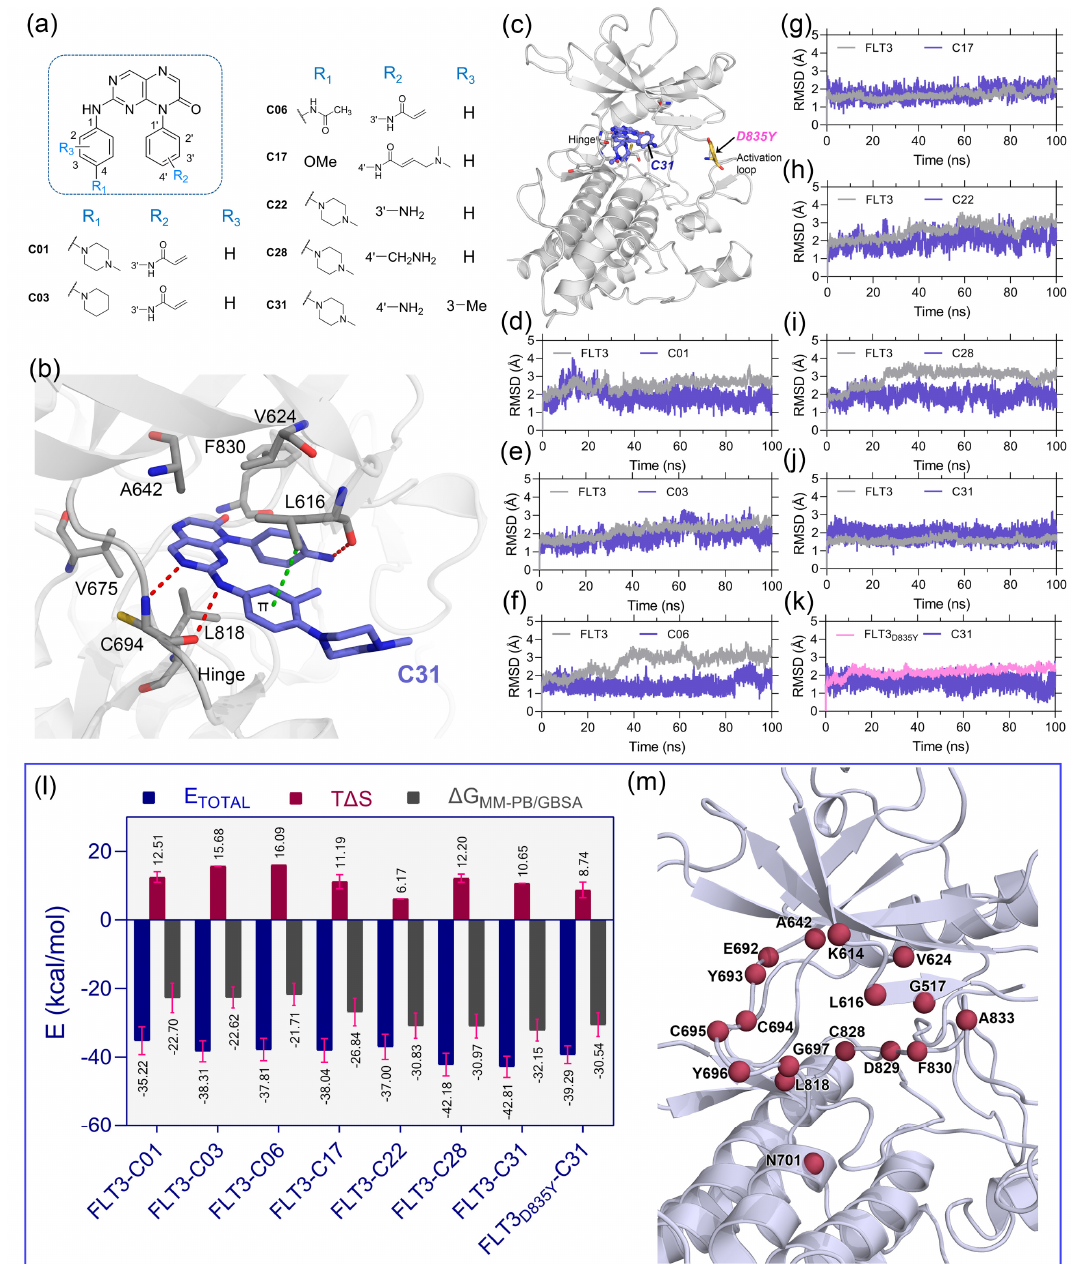
terms are shown in Table S2. The final ΔG (cid:2897)(cid:2897)(cid:2879)(cid:2900)(cid:2886)/(cid:2891)(cid:2886)(cid:2903)(cid:2885) values were estimated to be − 32.15 kcal/mol and − 30.54 kcal/mol for the C31-bound wild-type and mutant FLT3 complexes, respectively.